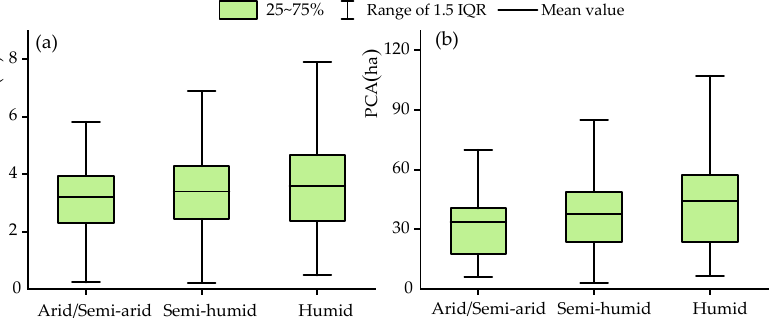
Figure 4. Differences of urban park cooling effects in different climatic regions: ( a ) is PCI, ( b ) is PCA.